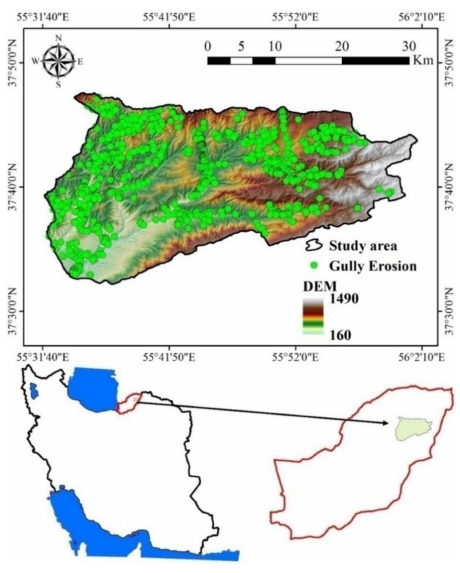
Figure 1. Location of the study area. Table 1. Land use classes in the study area.